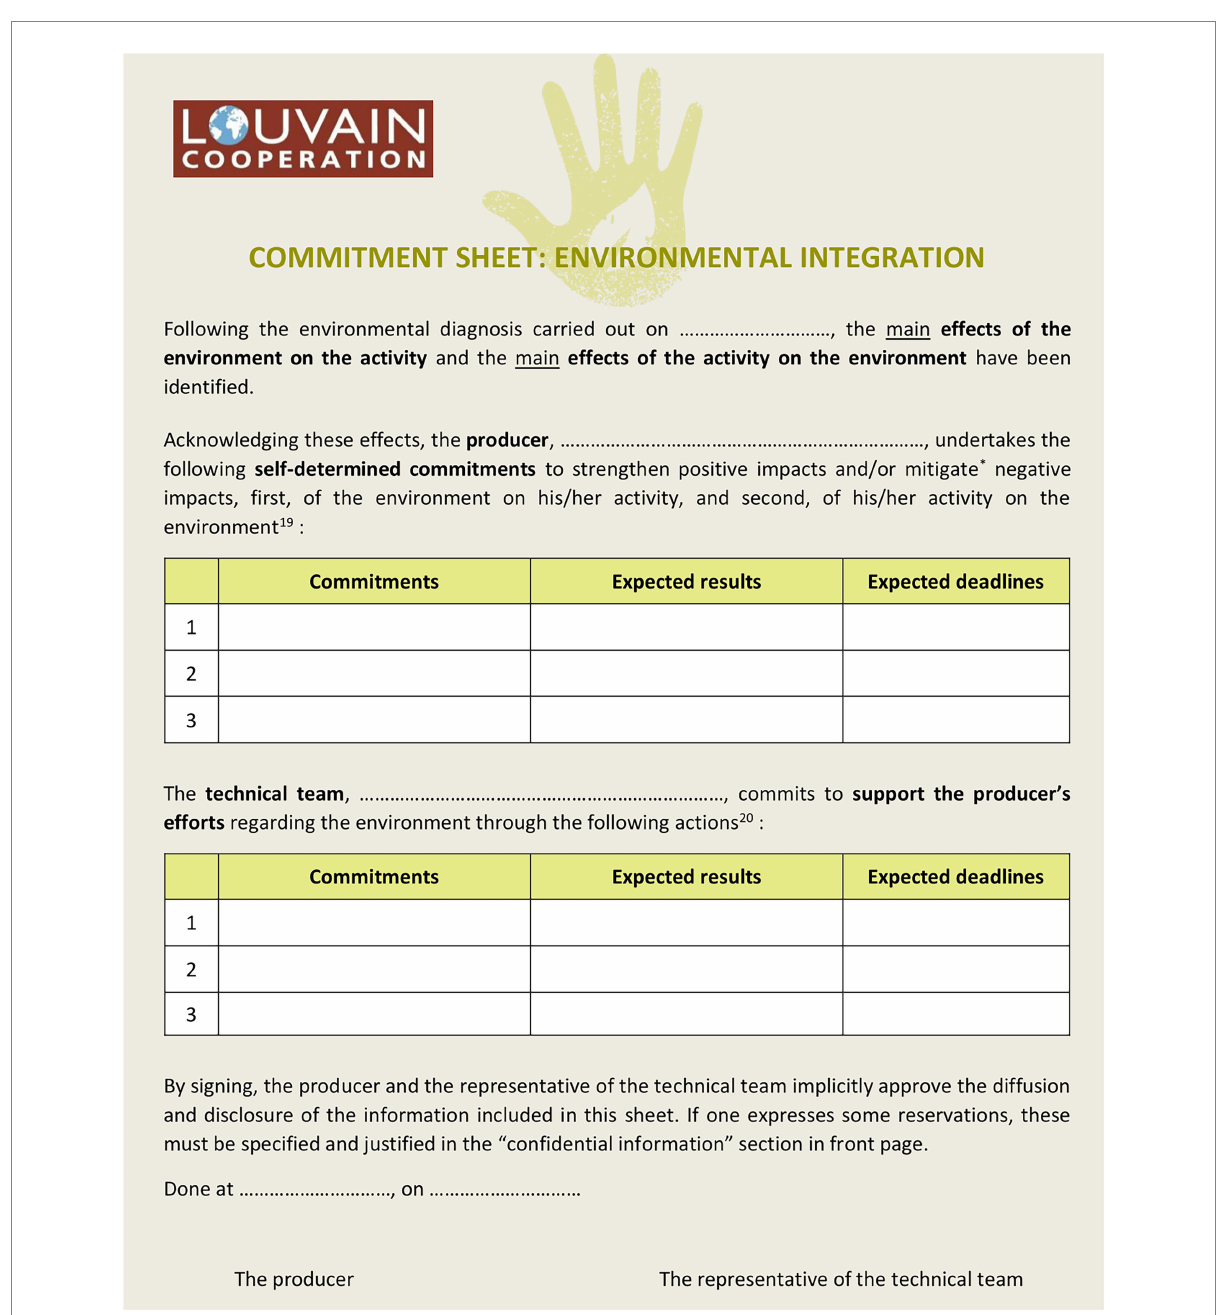
FIGURE 1 The commitment sheet/EIT